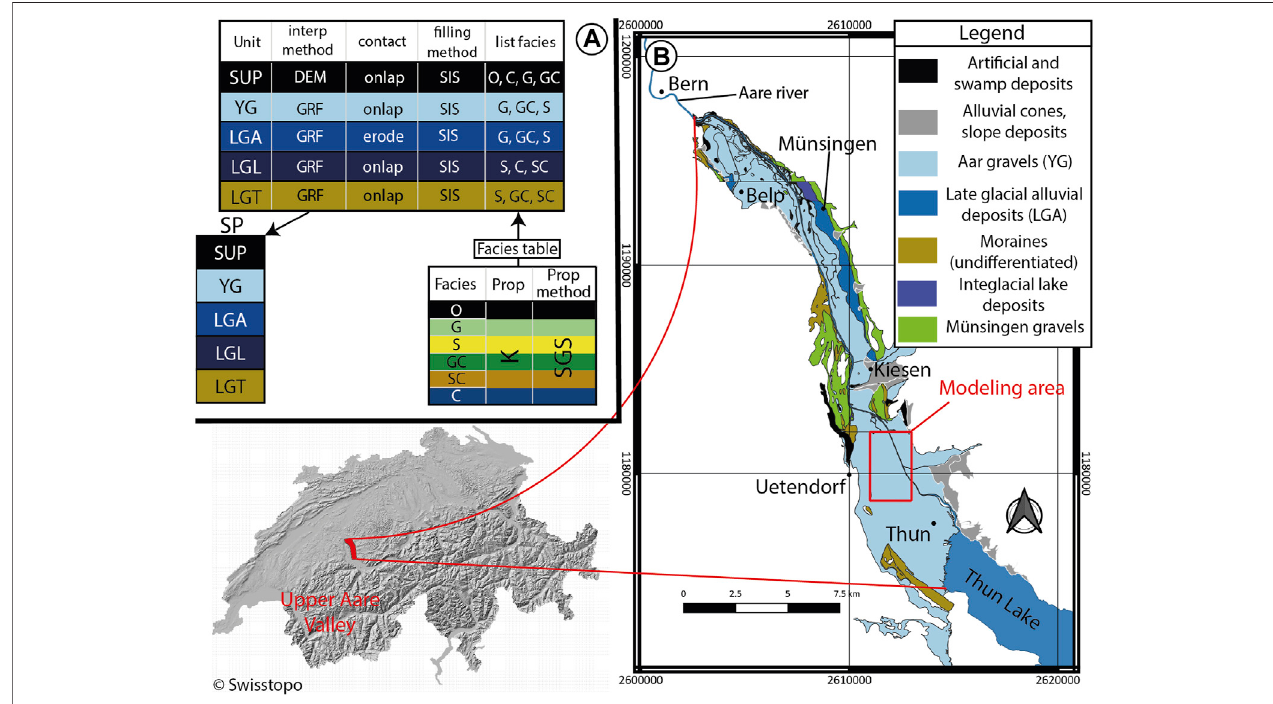
FIGURE 8| (A) Schematic stratigraphic pile used for the ArchPysimulations ofthe local geological models in the upper Aare Valley. It shows the differentunits that havebeentakenintoaccount,theirstratigraphicrelations(whichisabove/below(i.e.,younger/older)),thenatureofitscontact(erodeoronlap),theinterpolationmethods used or the lithofacies (see Table 2 ), and the property to simulate (hydraulic conductivity ( K ) using sequential Gaussian simulations (SGS)). See Section 2.2 for more details. (B) Situation and simpli fi ed geological map of the upper Aare Valley. Only unconsolidated deposits that are near the aquifer are shown. The moraines are represented undifferentiated. The coordinates are presented in CH 1903+ - LV95 (epsg: 2056). All the data used come from the Swiss Geological Survey (Swisstopo).